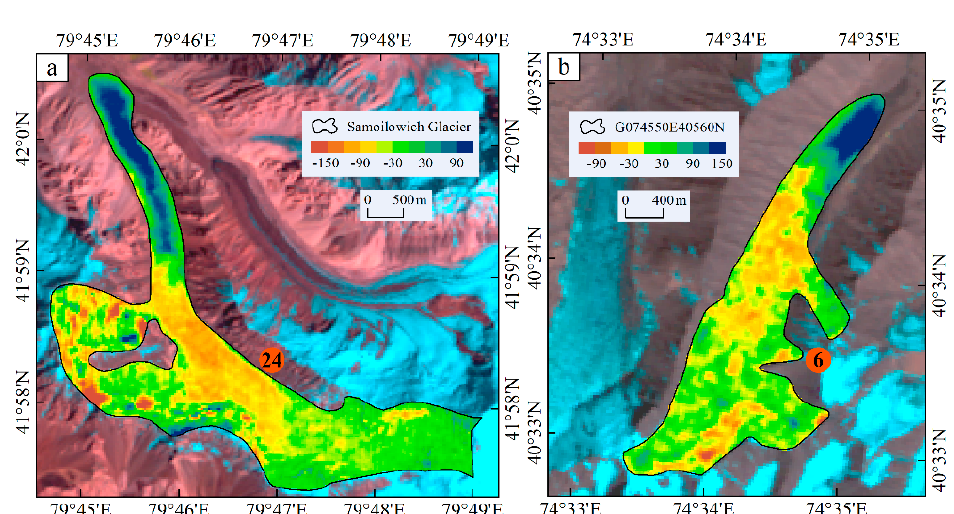
Figure 9. Surging glaciers in the Tien Shan Range. Figure shows glacial boundaries at the beginning and end of a surge using remote sensing images acquired at the end of the surging glacier (refer to Table 1 for glacier numbers): glaciers 19, 24, 4, 34, 10, 30, 28, 13, 6, and 5 acquired using Landsat Thematic Mapper (TM) and Enhanced Thematic Mapper (ETM+) imagery.